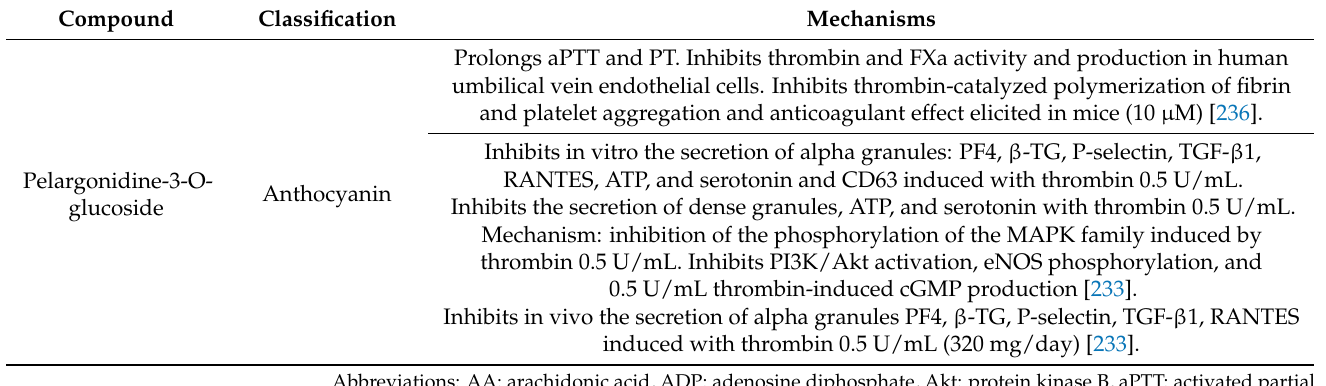
Pelargonidine-3-O- glucoside